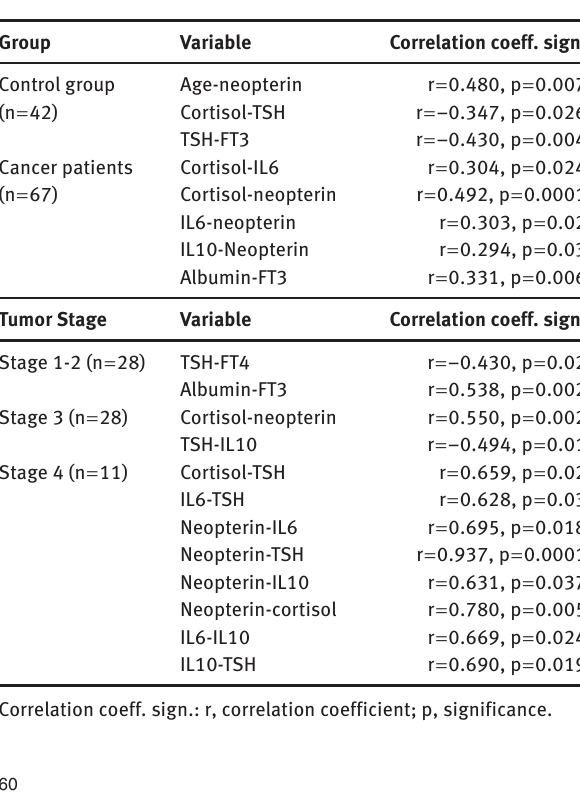
Table 3: Significant correlations (p < 0.05) between the variables of control group vs. gastrointestinal cancer cases.